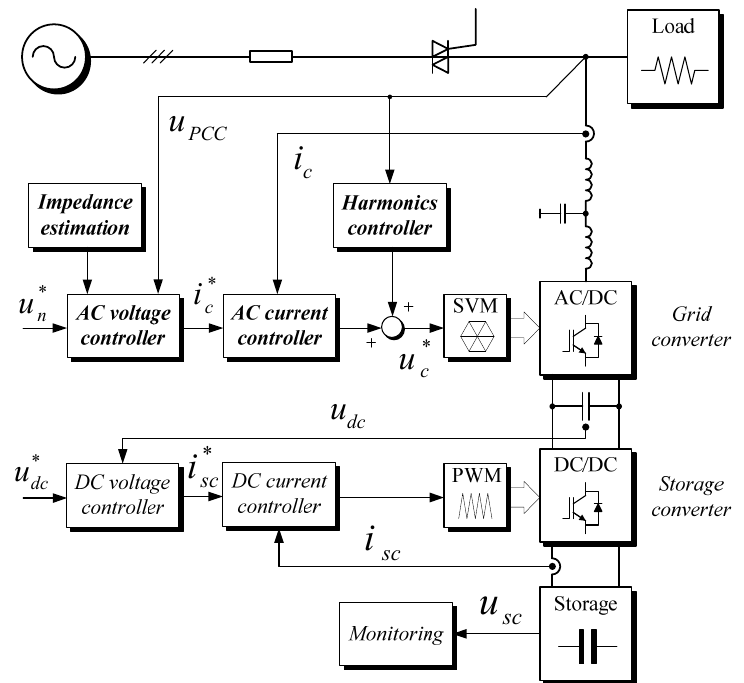
Figure 3. Block scheme of the proposed shunt-conditioner control system (* denotes reference values).